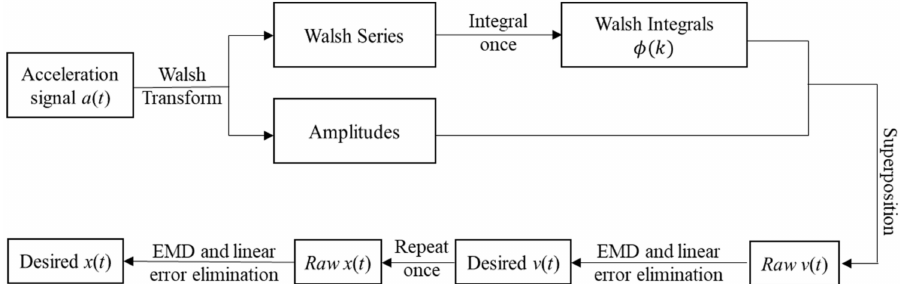
Figure 3. The flowchart of the Walsh transform and Empirical Mode Decomposition-based integral (WATEBI)